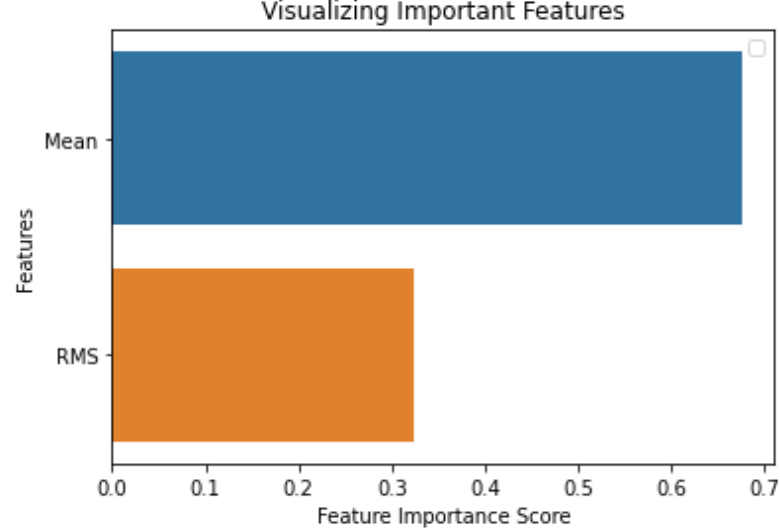
Figure 11. Feature importance.